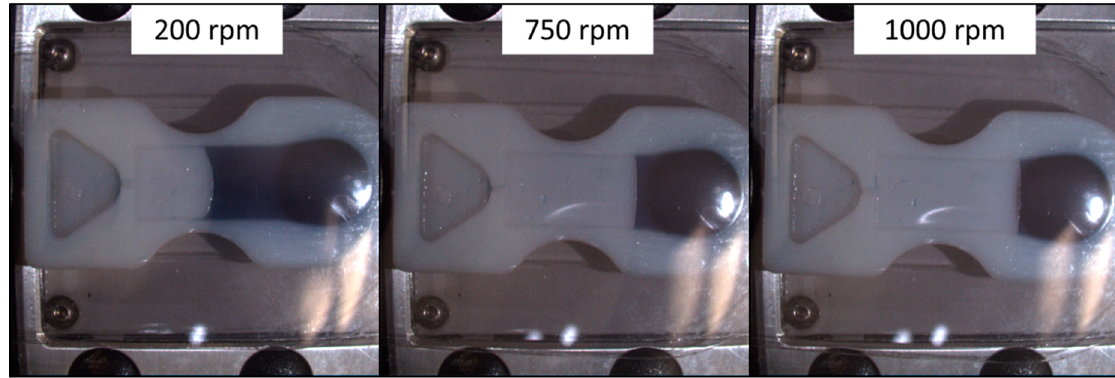
Figure 4. Fluid position in straight channel insert when spinning at 200 RPM, 750 RPM, and 1000 RPM respectively.